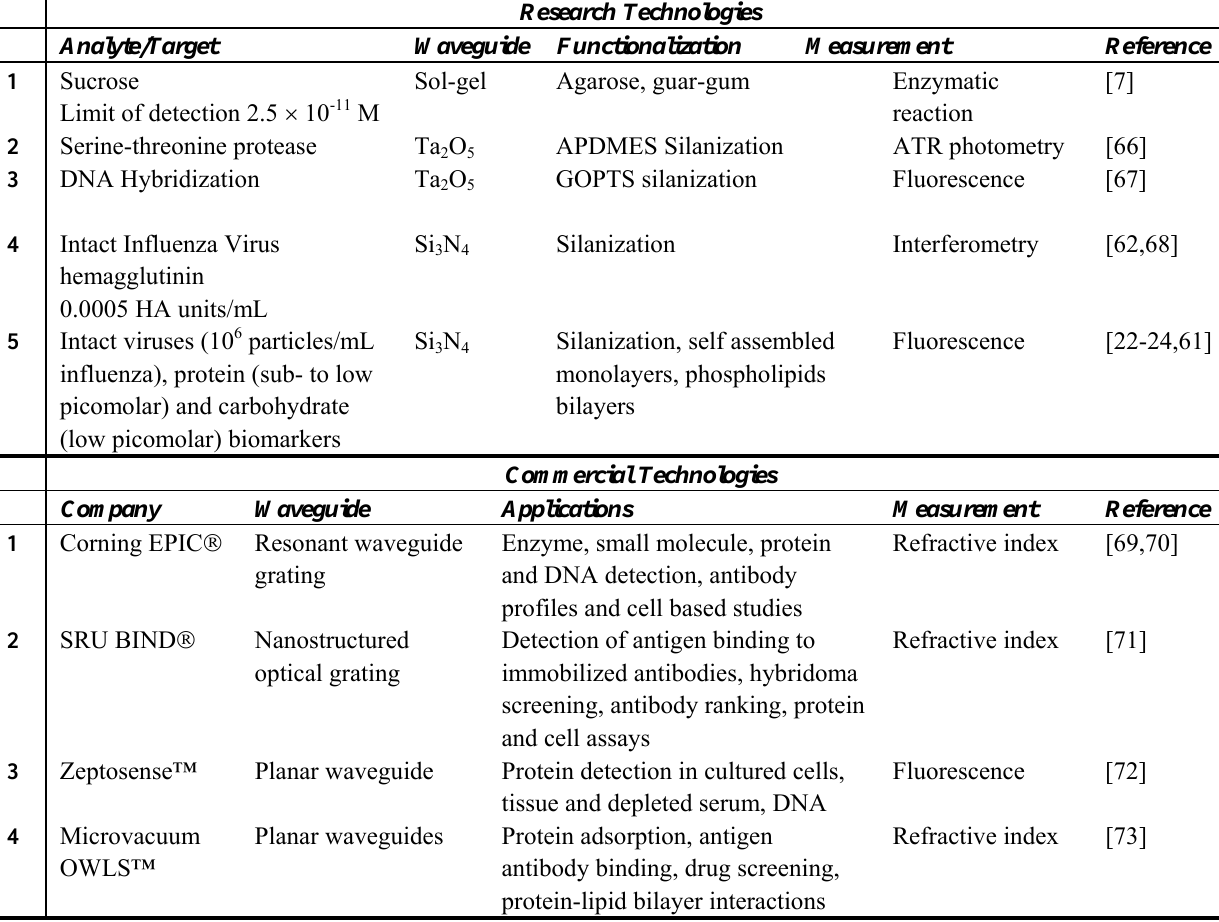
Table 2. Summary of select technologies, both research and commercial, that use Single Mode Planar Optical